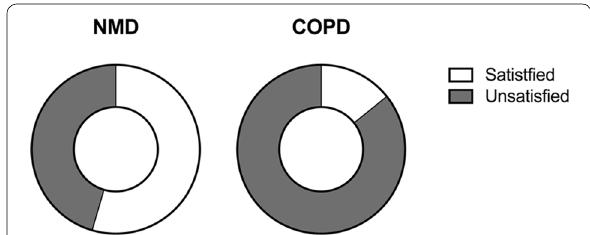
Fig. 4 Degree of satisfaction with mobilization according to underly- ing disease—question: Are you satisfied with your level of mobility? NMD neuromuscular disease, COPD chronic obstructive pulmonary disease